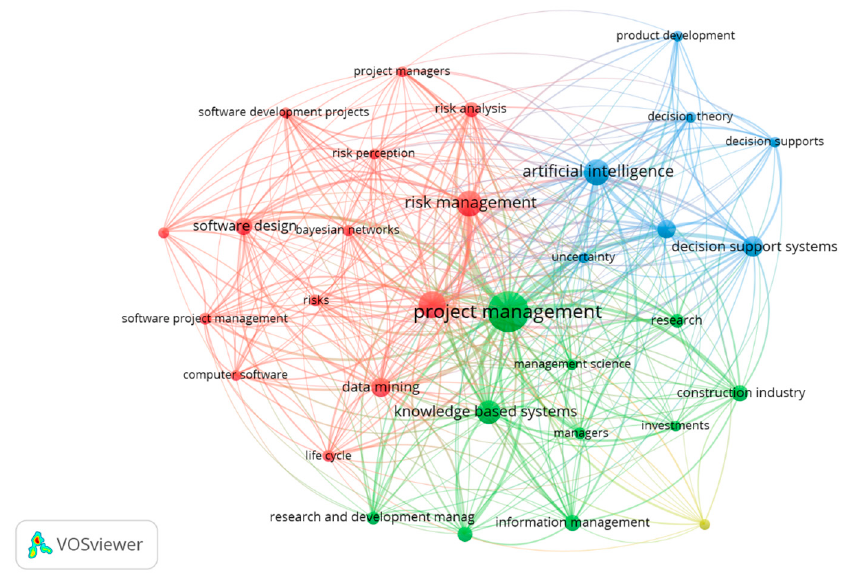
Figure 11. Clusters identified in the Uncertainty domain.